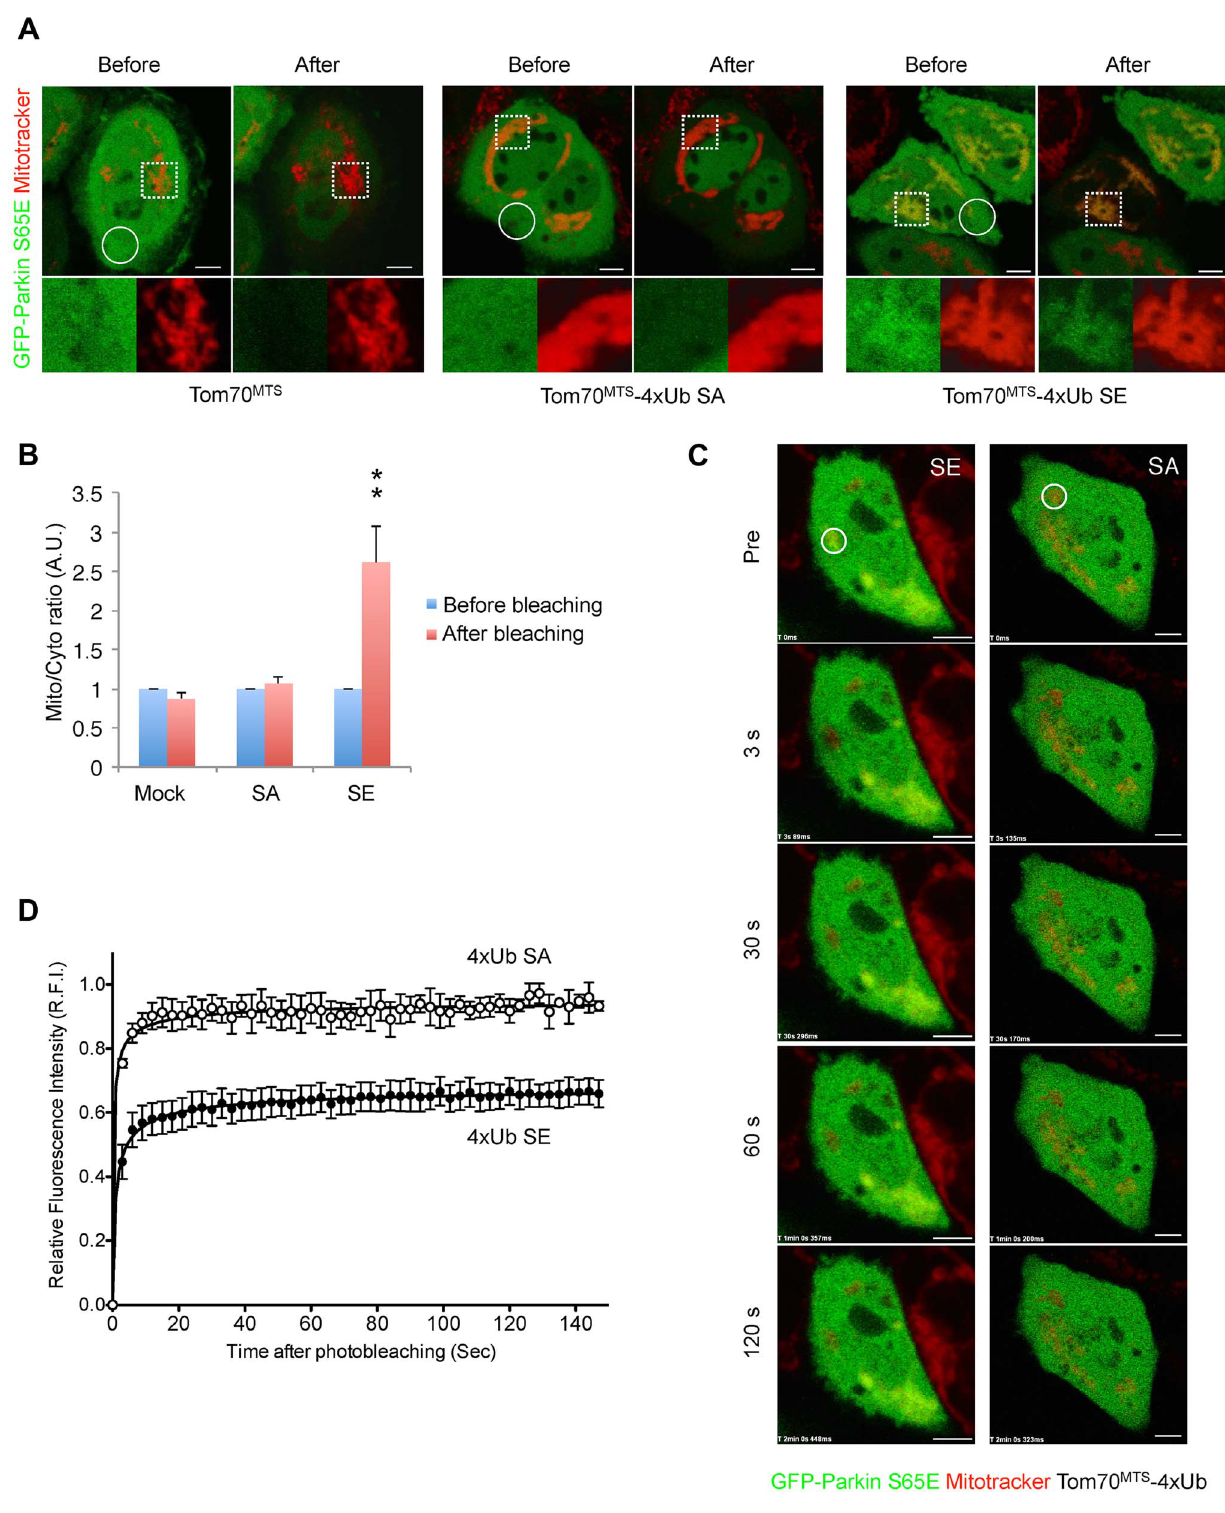
Figure6.Mitochondriallytargetedphospho-mimetic4 6 UbanchorsParkin. ( A )FLIPanalysis.MitochondriaofHeLacellstransfectedwithGFP- Parkin S65E (green) along with Tom70 MTS , Tom70 MTS -4Ub SA or SE were visualized with MitoTracker Red (red). Representative live cell images obtained before and after pulse photobleaching in the circled region was shown. Higher magnification images of the dashed square area were also shown in separated color channels at the bottom. ( B ) The ratios of averaged fluorescence intensity in mitochondrial and cytosolic regions (Mito/Cyto ratio, 4 m m 2 each) were graphed (mean 6 SEM, n=4–6). ** p , 0.01 by two-tailed unpaired Student’s t -test. ( C ) FRAP analysis. HeLa cells transfected with GFP-Parkin WT along with Tom70 MTS -4Ub SA or SE were treated with 2 m M a proteasome inhibitor MG132 for 3 hrs to avoid degradation of activated Parkin and mitochondria were visualized with MitoTracker Red. MG132 treatment had little effect on the molecular behavior of GFP-Parkin